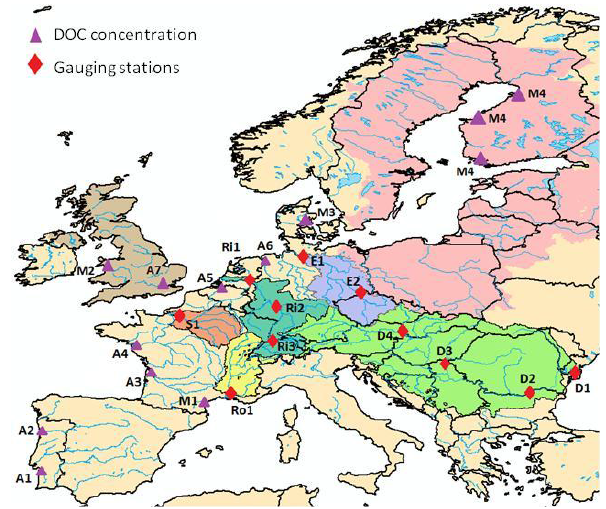
Figure 3. Map of continental Europe delineating the (group of) catchments of focus in this study and the location of observed dis- charge and DOC concentrations. Catchments, from west to east, are All UK (light brown), Seine (orange), Rhône (yellow), Rhine (dark green), Elbe (violet), All Baltic (pink) and Danube (light green). Observations include the GRDC stations (red diamonds) in the Seine (S1 – Poses), Rhône (Ro1 – Beaucaire), Rhine (Ri1